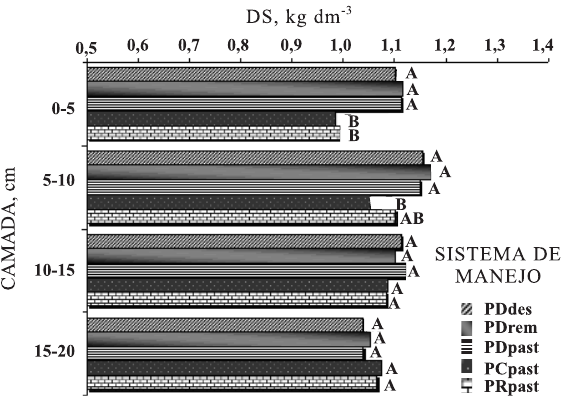
Figura 4. Densidade do solo (DS) nos sistemas de manejo e camadas na integração agricultura- pecuária. Média de três épocas: 16, 88 e 190 DAS. Otacílio Costa-SC, 2003/2004. Letras maiúsculas comparam os sistemas de manejo em cada camada. Médias seguidas por letras iguais não diferem a 5 %